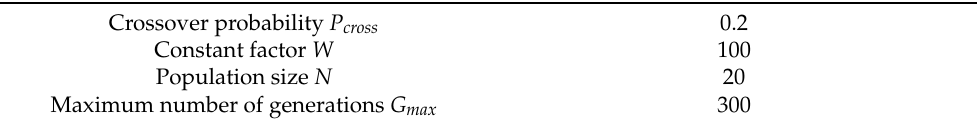
Table 6. Parameter values of the DE algorithm.